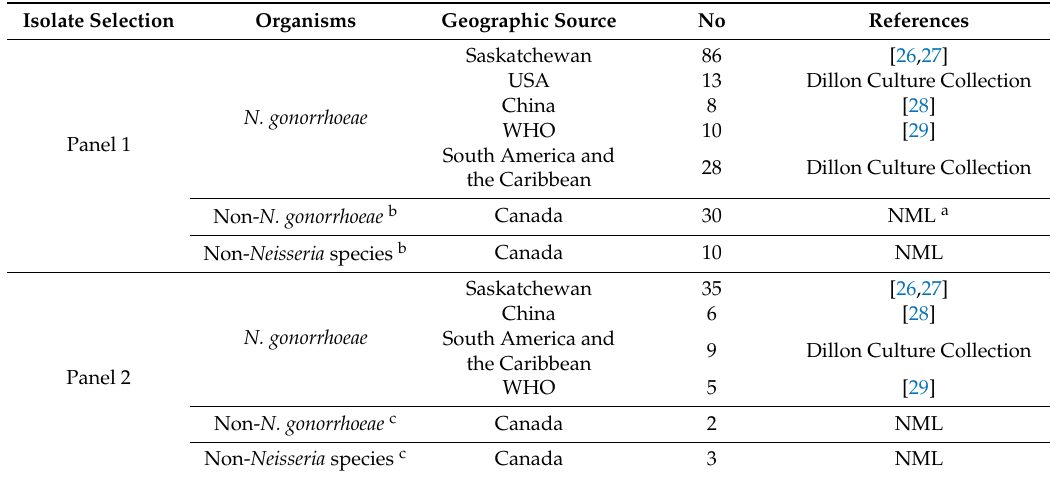
Table 4. N. gonorrhoeae , non- N. gonorrhoeae , and non- Neisseria isolates used in this study.